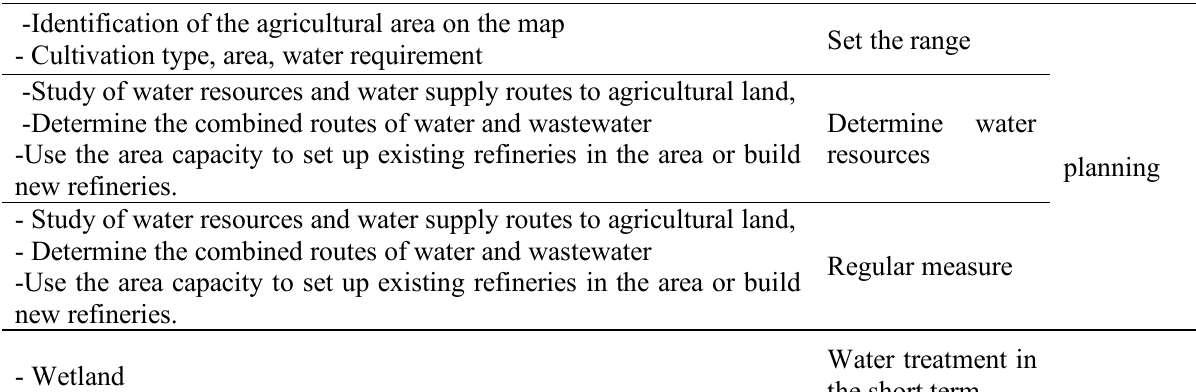
Table 14 . Environmental Management Plan (EMP) for safe use of wastewater for irrigation of south of Tehran - Identification of the agricultural area on the